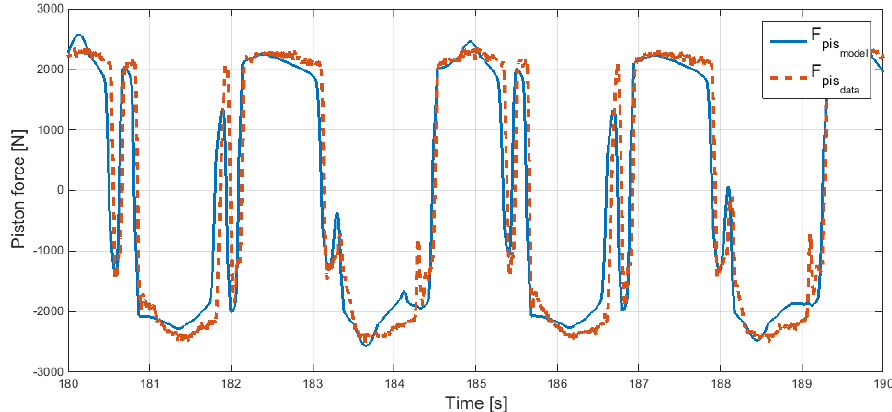
Figure 14. Pressure in the chambers A and B of the hydraulic cylinder from the experiments and the mathematical model for the constant-pressure configuration.